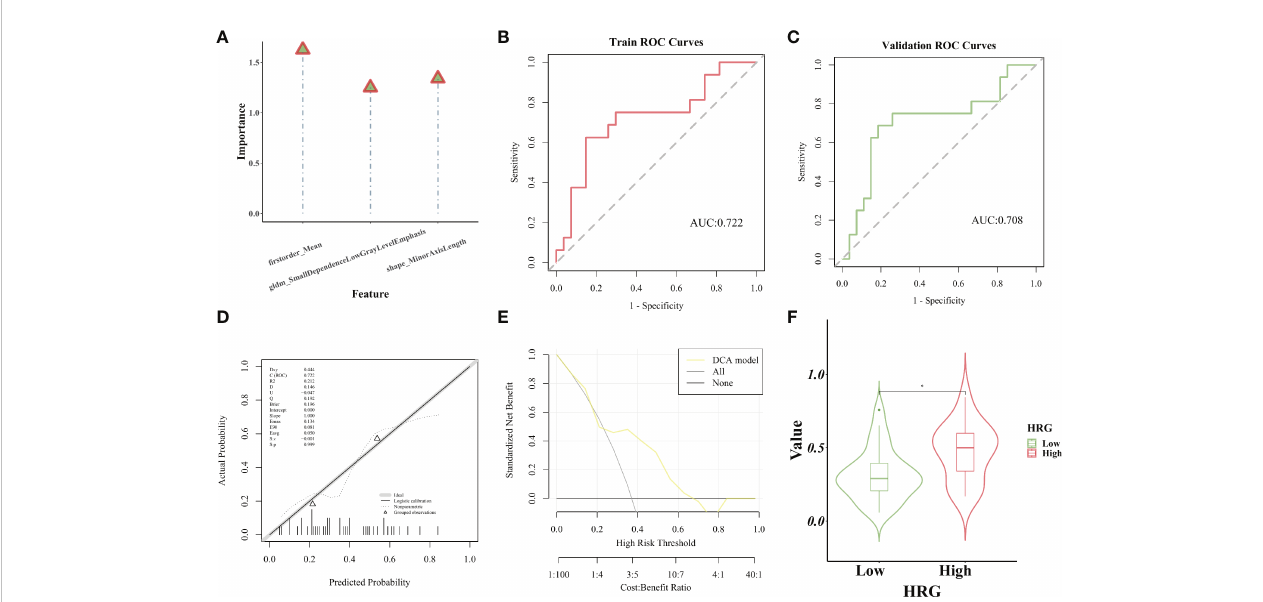
FIGURE 6 Establishment and evaluation of logistic regression model. (A) . The importance of screened features in LR algorithm; (B) . The model ’ s AUC value in the training set; (C) . The model ’ s AUC value in the veri fi cation set; (D) . The calibration curve displays the probability of high HRG expression; (E) . DCA curve displays high clinical practicability of the model; (F) .Rad_score was higher in HRG high expression group. * represent p < 0.05.